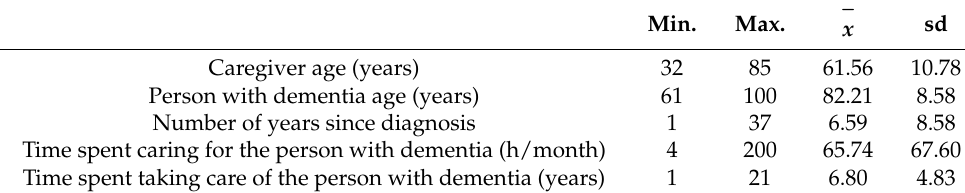
Table 2. Sociodemographic characteristics.